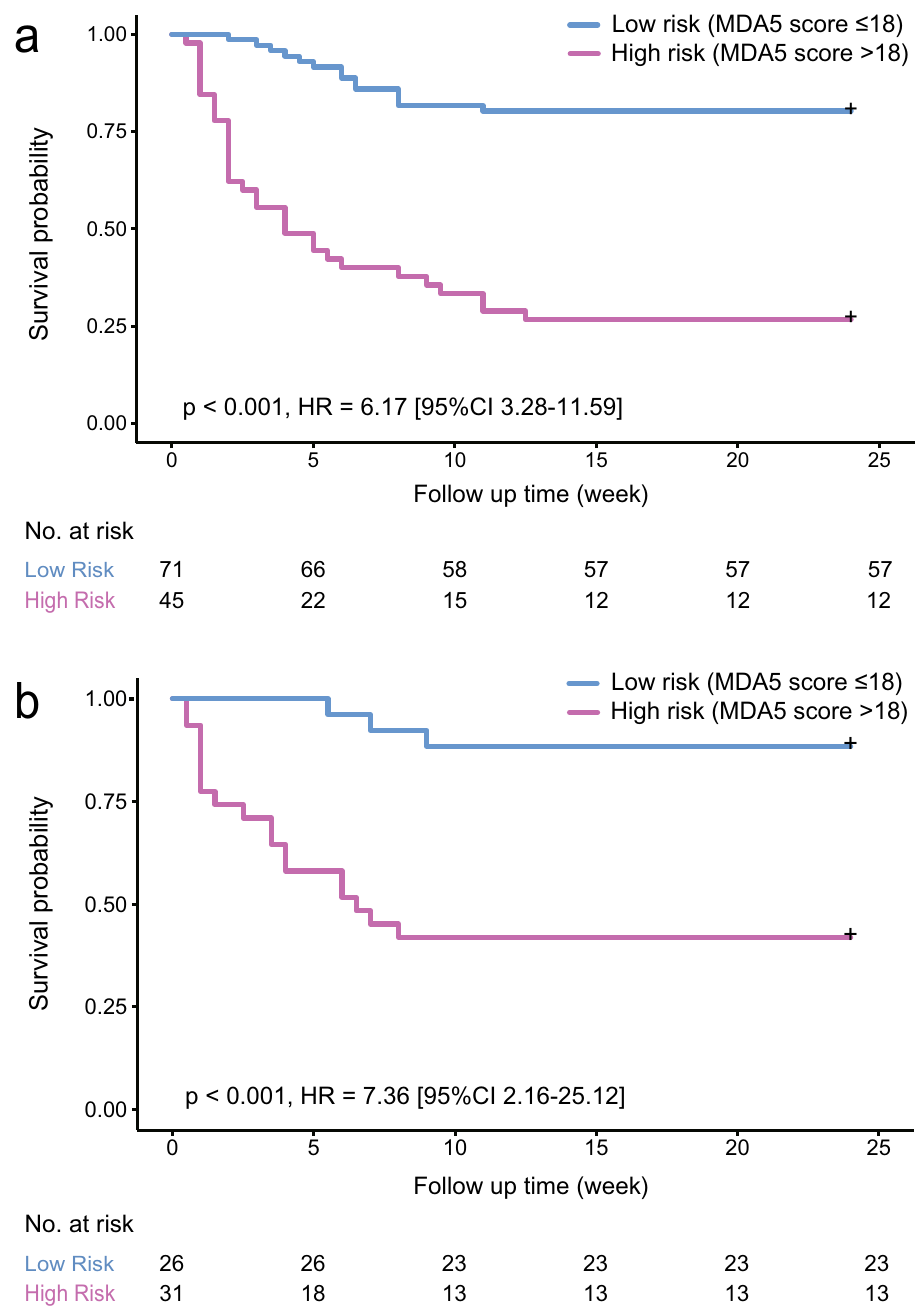
Figure 2. Survival curves of ‘MDA5 score’ in the derivation ( a ) and validation ( b ) datasets. MDA5, melanoma differentiation-associated gene 5; HR, hazard ratio; 95%CI, 95% confidence